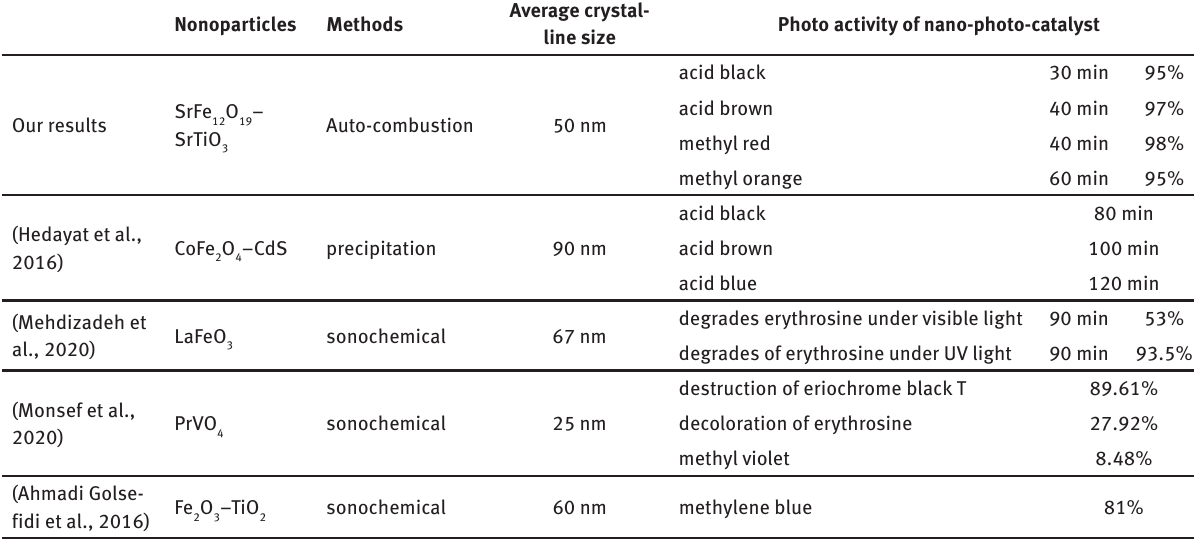
Table 2: Related published works about photocatalytic